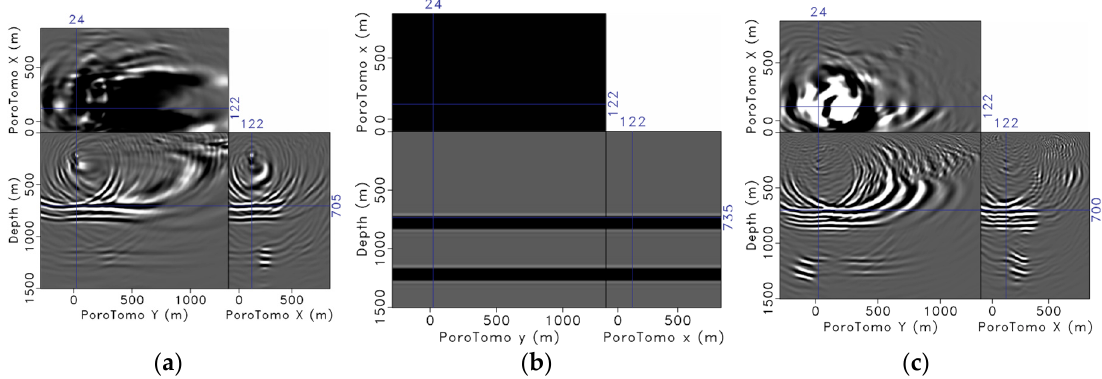
Figure 6. Reverse-time migration (RTM) result from two flat layers (four reflectors) at 700 m and 1100 m depth. ( a ) P–P imaging, ( b ) the reflectivity model used in RTM and ( c ) P–S imaging.